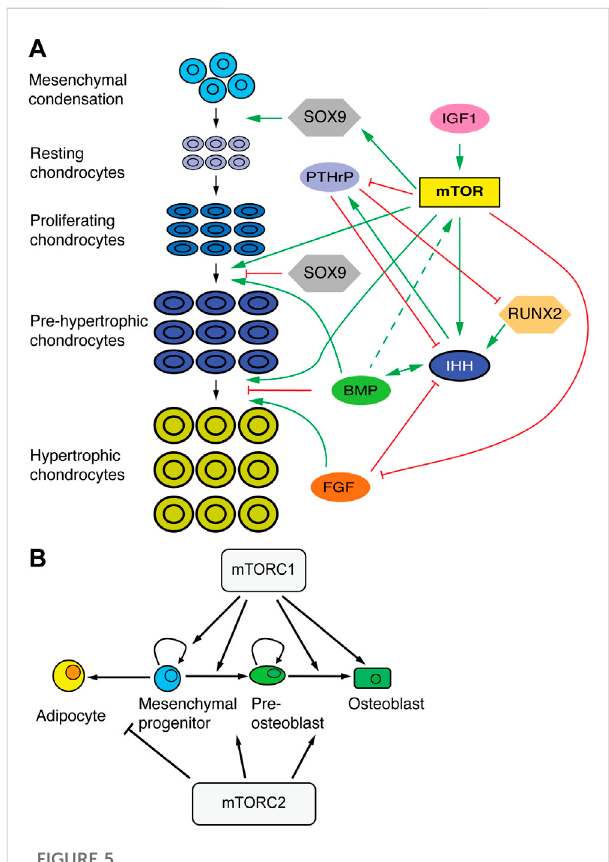
FIGURE 5 mTOR in skeletal development. (A) Schematic of chondrocyte transitions during cartilage growth and their regulators. mTOR plays an integrative role at the intersection of progenitor/stem cell proliferation, chondrocyte differentiation and cell size control. (B) Effects of mTORC1 and 2 in the differentiation of mesenchymal progenitors. Based on (Chen and Long,